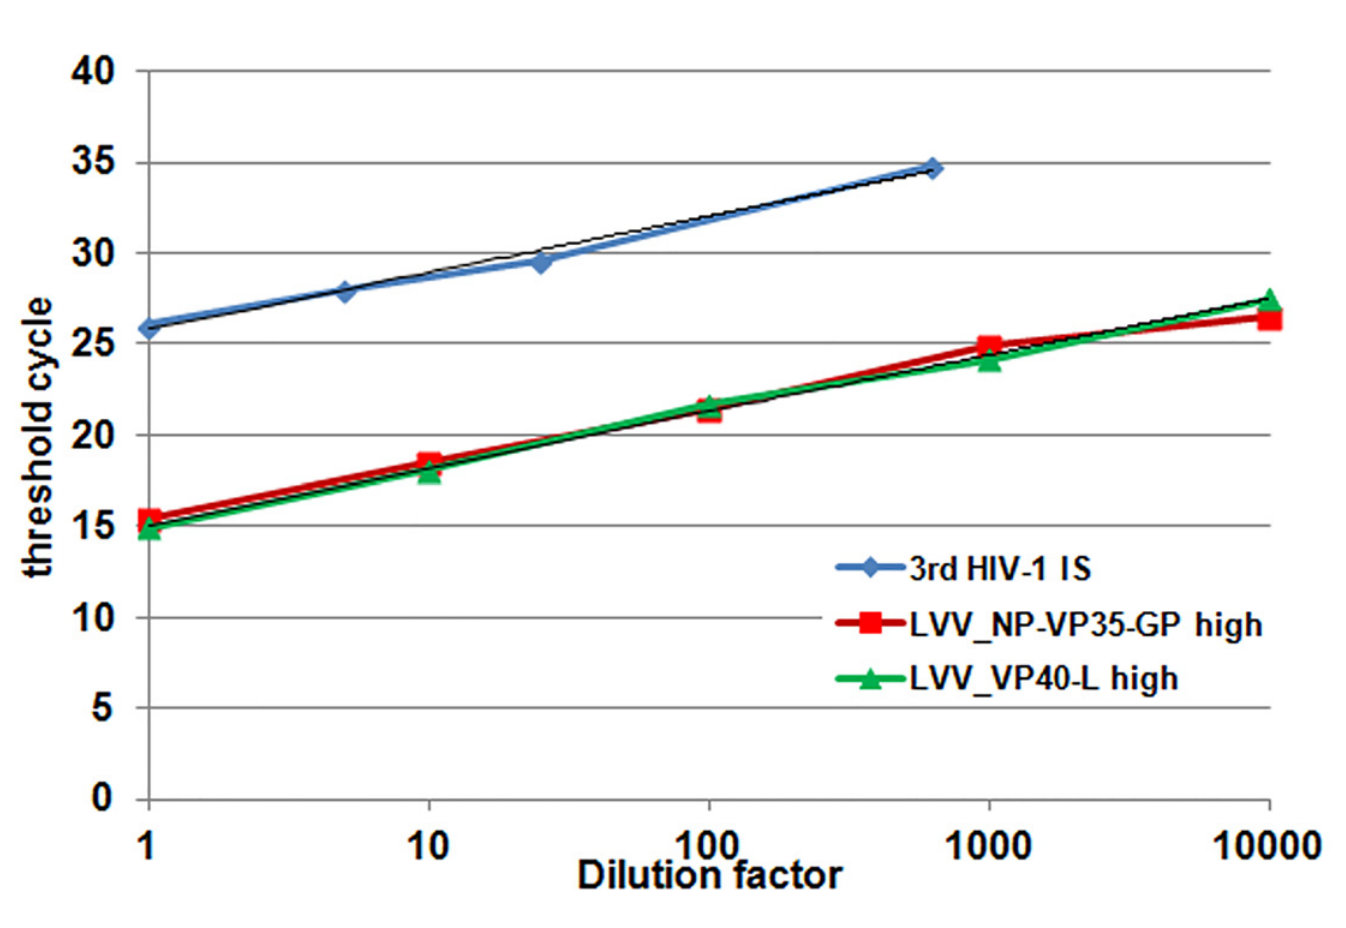
Fig 3. Efficiency of the quantitative RT-PCR targeting HIV LTR. Viral RNA extracted from serial dilutions of WHO 3 rd HIV-1 International standard (dilution factor 5, blue), LVV_NP-VP35-GP high (dilution factor 10, red) and LVV-VP40-L (dilution factor 10, green) were processed in duplicate in a quantitative RT-PCR using primers and probes annealing within the U5 region of the HIV-1 LTR. The graph shows a representative result of 3 independent experiments; the efficiencies of the reaction between samples were similar as represented by the slope of linear regression: HIV-1 IS = 3.122, LVV_NP-VP35-GP = 3.142, LVV_VP40-L =